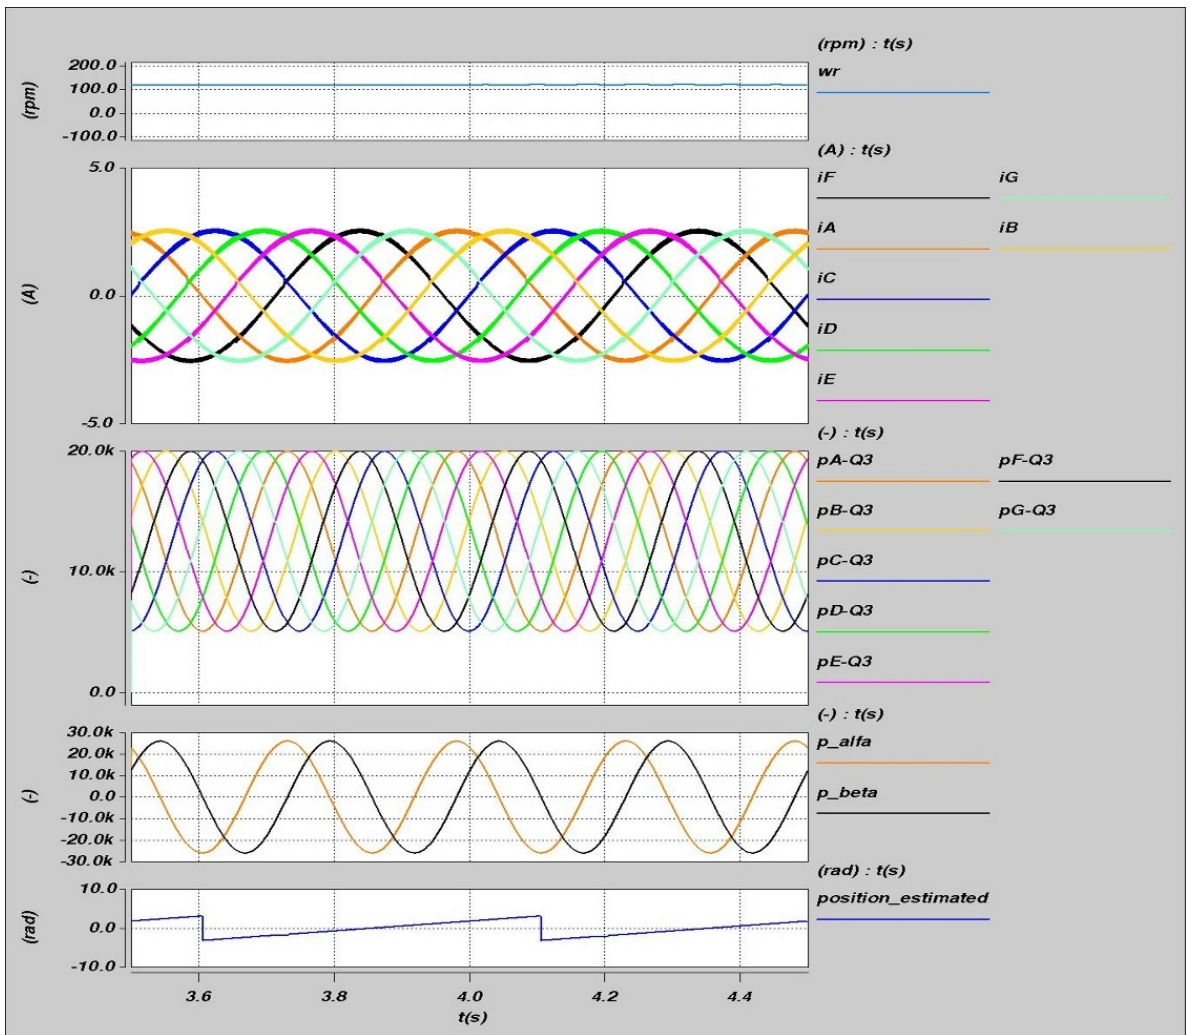
Figure 13. Saliency tracking results using active vector Q3 (case = 2).